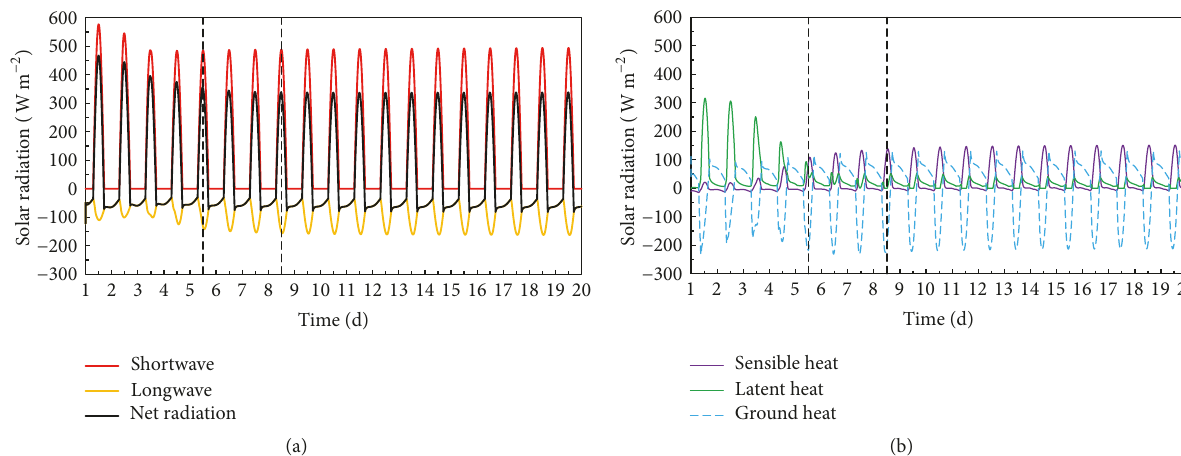
Figure 6: Simulated diurnal variations in surface energy balance components (namely, shortwave radiation, long radiation, net radiation, sensible heat flux, latent heat flux, and surface heat flux) during a 20-day drying period following a rainfall event.